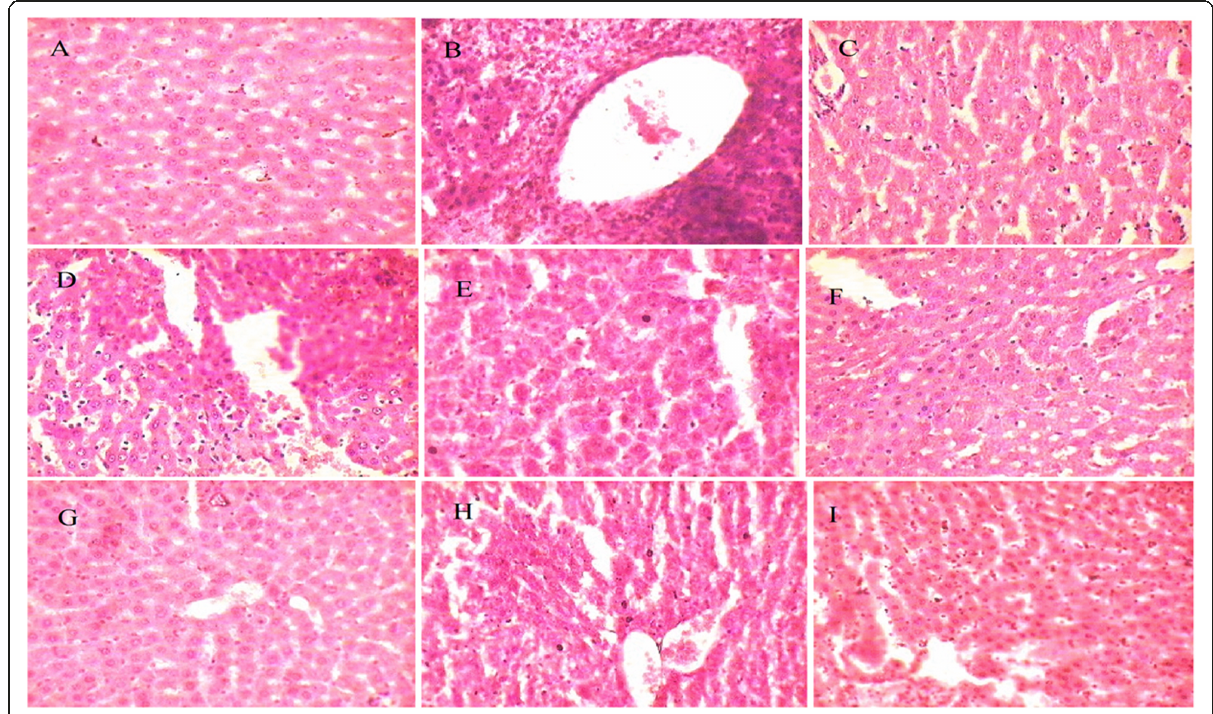
Fig. 1 Effect of fractions of LCME on histopathological changes in liver of rats in paracetamol induced hepatotoxicity in rats. Done by using Digital Motic Microscope, Magification 100X. a = Normal, b = Toxic, c = Standard, d = TLF-LCME 50, e = TLF-LCME 100, f =BNF-LCME 50, g = BNF- LCME 100, h = AQF-LCME 50, i = AQF-LCME 100, TLF-LCME: Toulene fraction of methanolic extract fraction of Lindernia ciliata ; BNF-LCME: Butanol fraction of methanolic extract fraction of Lindernia ciliata ; AQF-LCME: Aqueous fraction of methanolic extract fraction of Lindernia ciliata